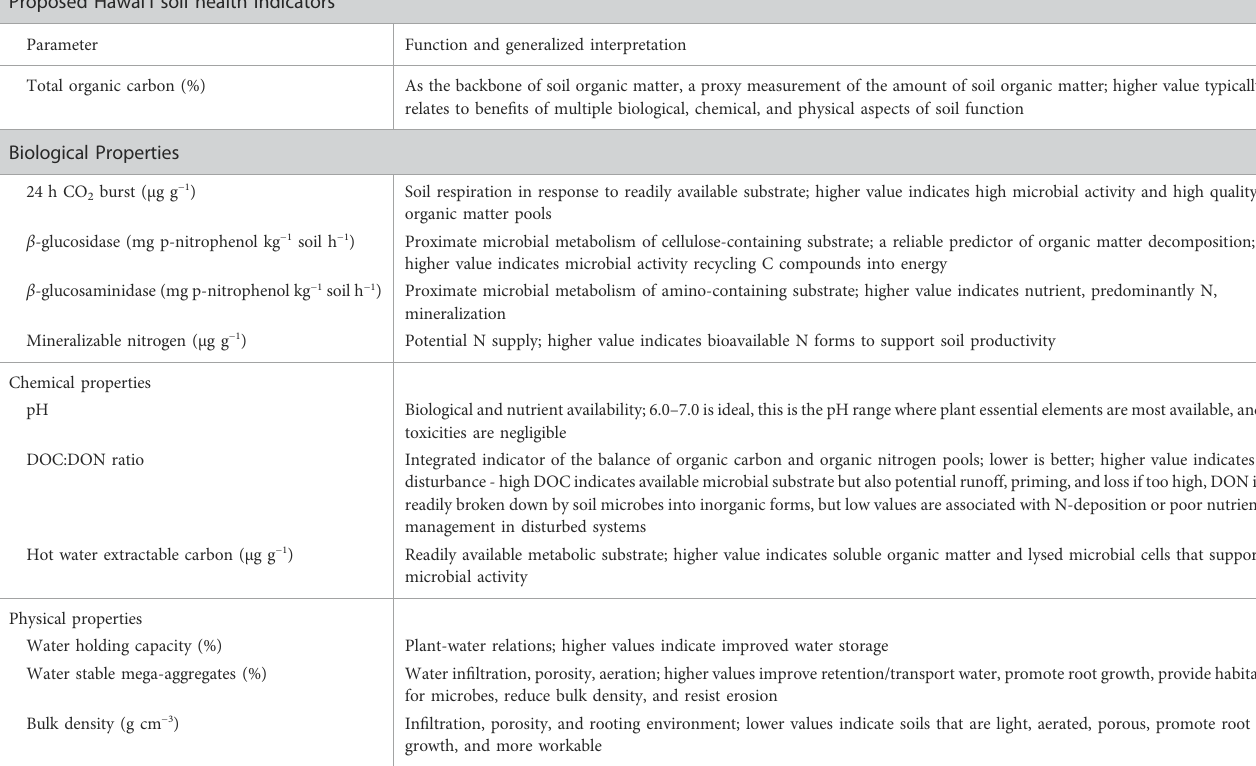
TABLE 3 After assessing the sensitivity, interpretation value, and feasibility (i.e., resources required for fi eld collection and laboratory assays), the recommended indicators to use in a routine soil health test for Hawai ʻ i and potentially other tropical-subtropical and volcanic regions, were reduced to 11